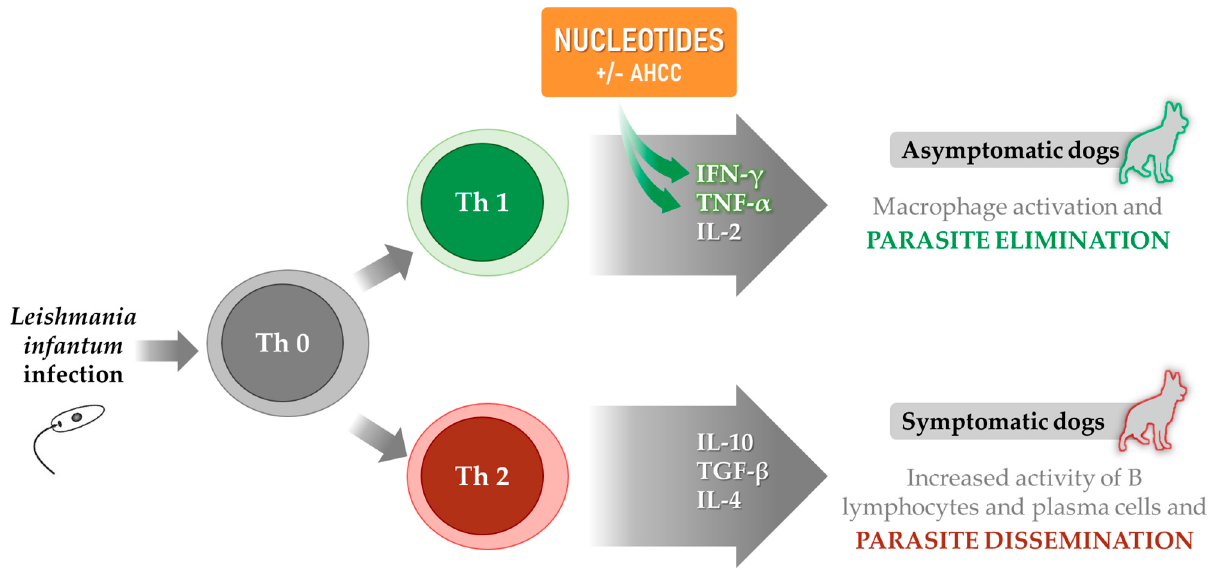
Figure 1. Enhancement of the effective Th1 immune response mediated by nucleotides, with or without AHCC, by increasing IFN- γ and TNF- α release. Adapted from Baneth et al. 2008 [31]; and Barbiéri et al., 2006 [17].